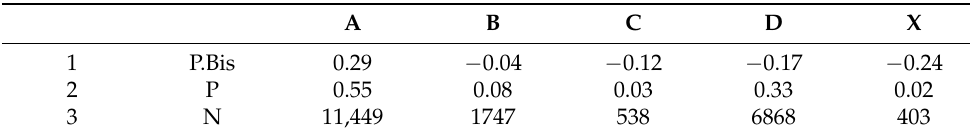
Table 1. Item analysis of the first task.